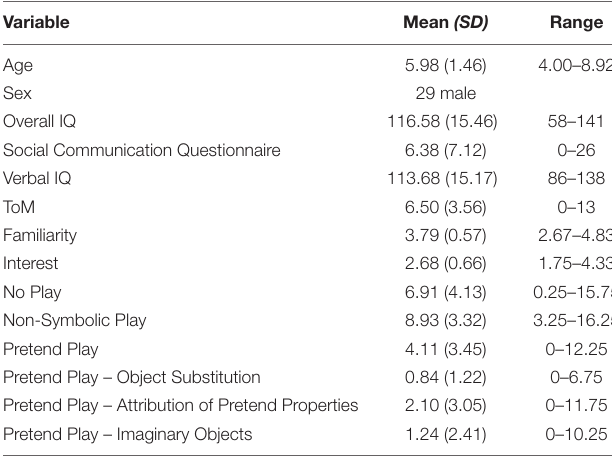
TABLE 1 | Participant descriptive statistics ( N =